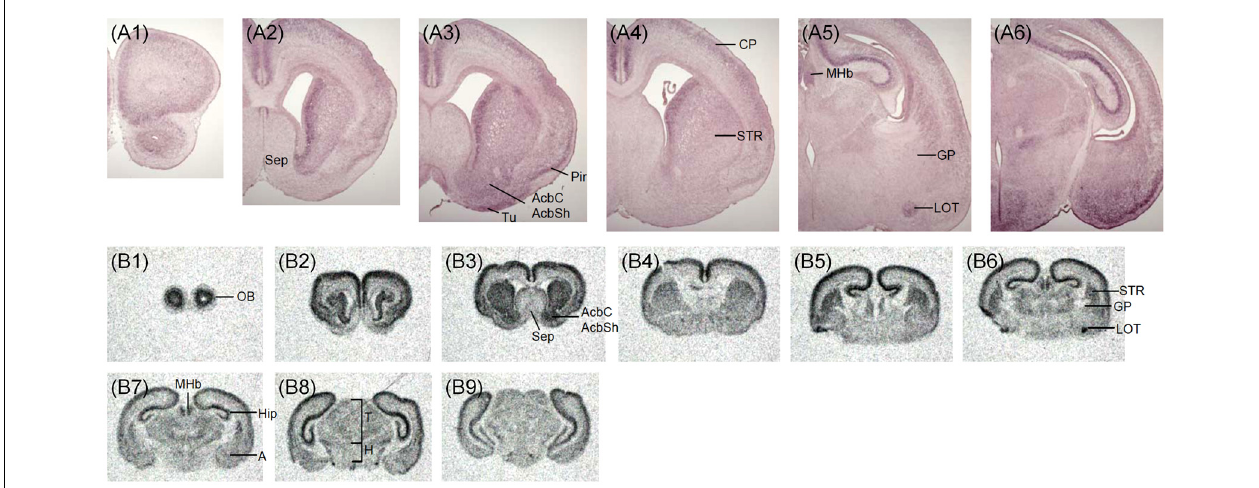
FIGURE 5 | Zswim6 mRNA expression pattern in E17.5 mouse forebrain. Expression pattern of Zswim6 mRNA detected by in situ hybridization with digoxigenin-labeled probes (A1–A6) and 35 S-labeled probes (B1–B9) from rostral to caudal levels. A, amygdala; AcbC, nucleus accumbens, core; AcbSh, nucleus accumbens, shell; CP, cortical plate; GP, globus pallidus; H, hypothalamus; HIP, hippocampus; IZ, intermediate zone; LOT, nucleus of the lateral olfactory tract; MGE, medial ganglionic eminence; MHb, medial habenular nucleus; Pd, pallidum primordium; Pir, piriform cortex; POA, preoptic area; Sep, septum; SVZ, subventricular zone; T, thalamus; Tu, olfactory tubercle.